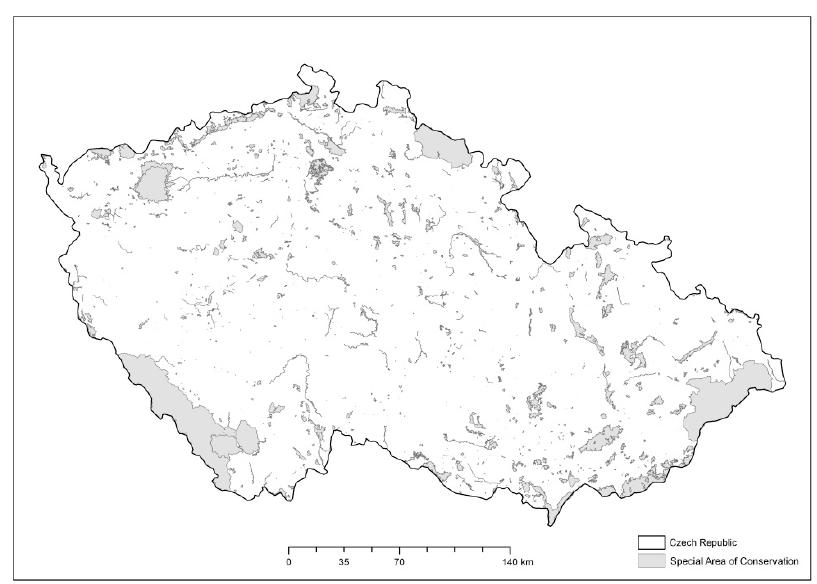
Figure 1. Network of Special Areas of Conservation (SAC) in the Czech Republic.